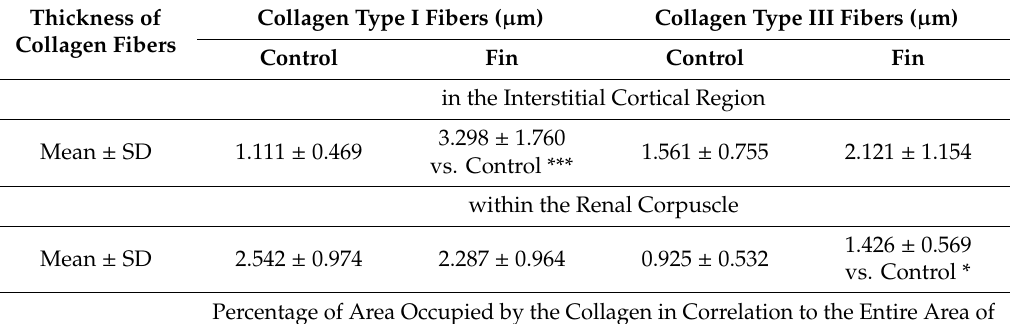
Table 5. Average thicknesses of type I and type III collagen fibers in the interstitial cortical region and within the renal corpuscle; and percentage contents of collagen in the cortex of control and finasteride-treated rats’ kidneys.